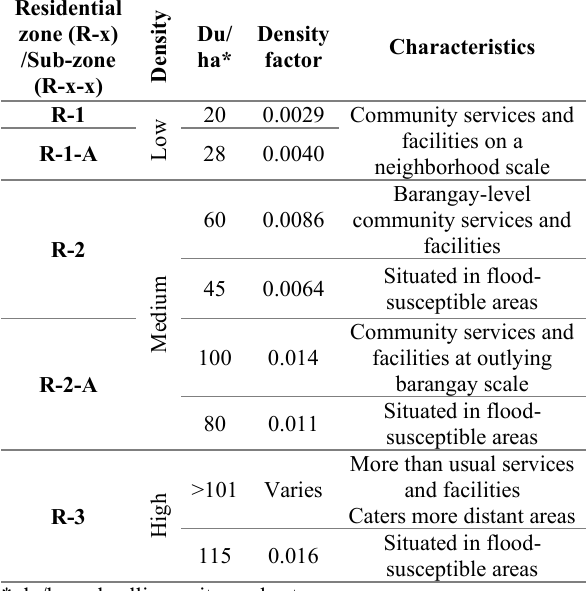
Table 1. Residential Zone/Subzone Classification (Quezon City Government, 2016)